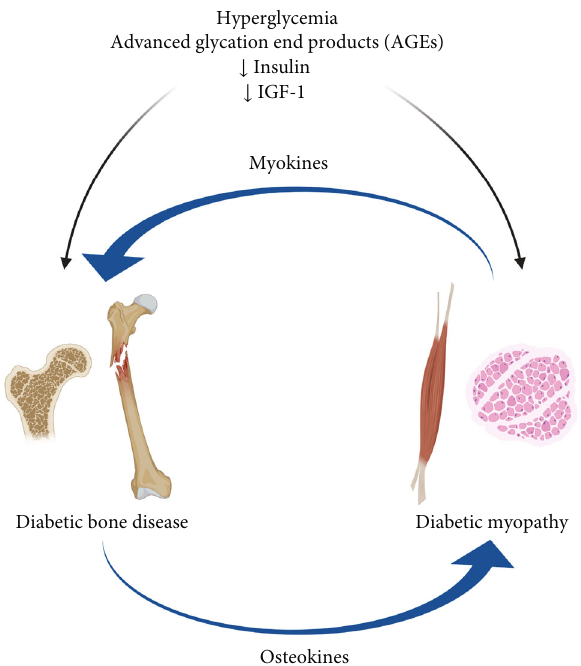
Figure 1: Common underlying mechanisms of diabetic bone disease and diabetic myopathy in type 1 diabetes (created with